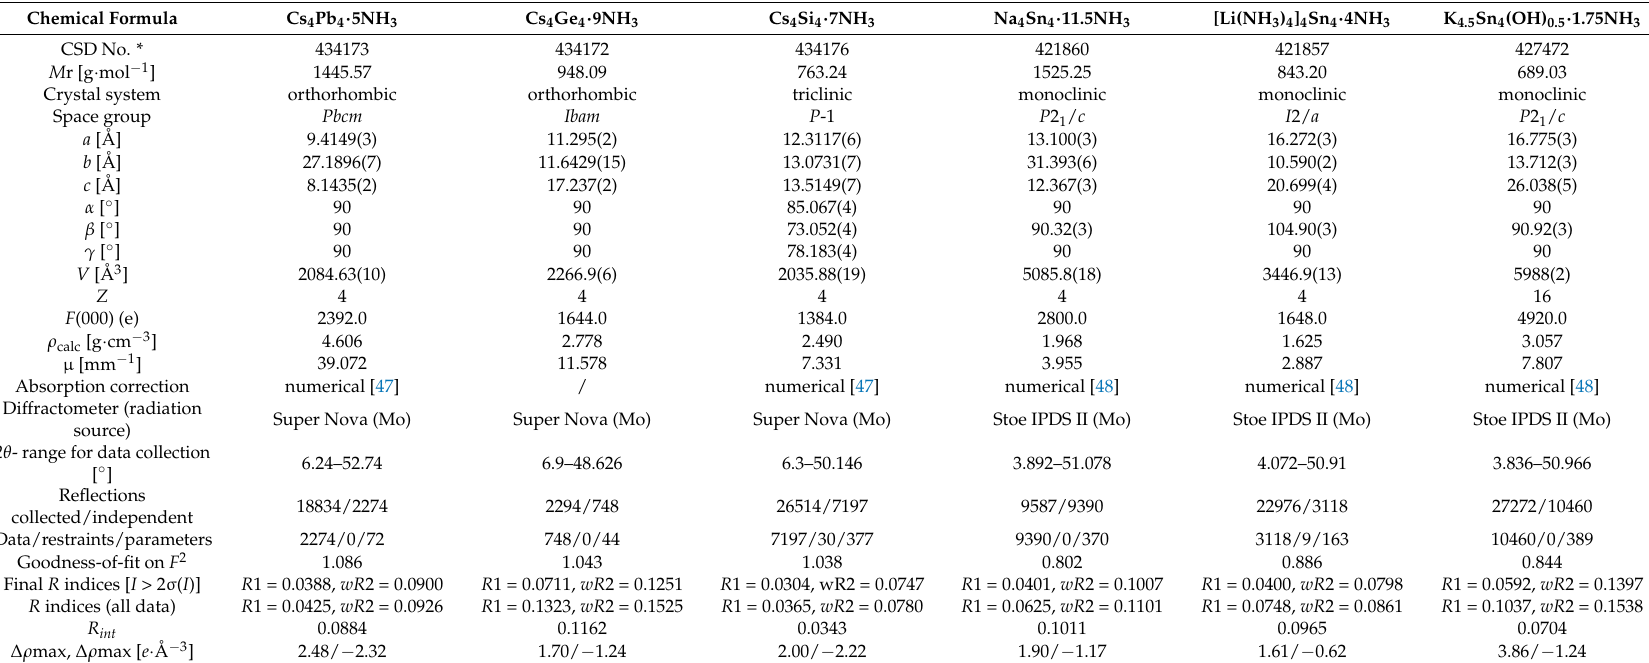
Table 3. Crystal structure and structure refinement details for the compounds described